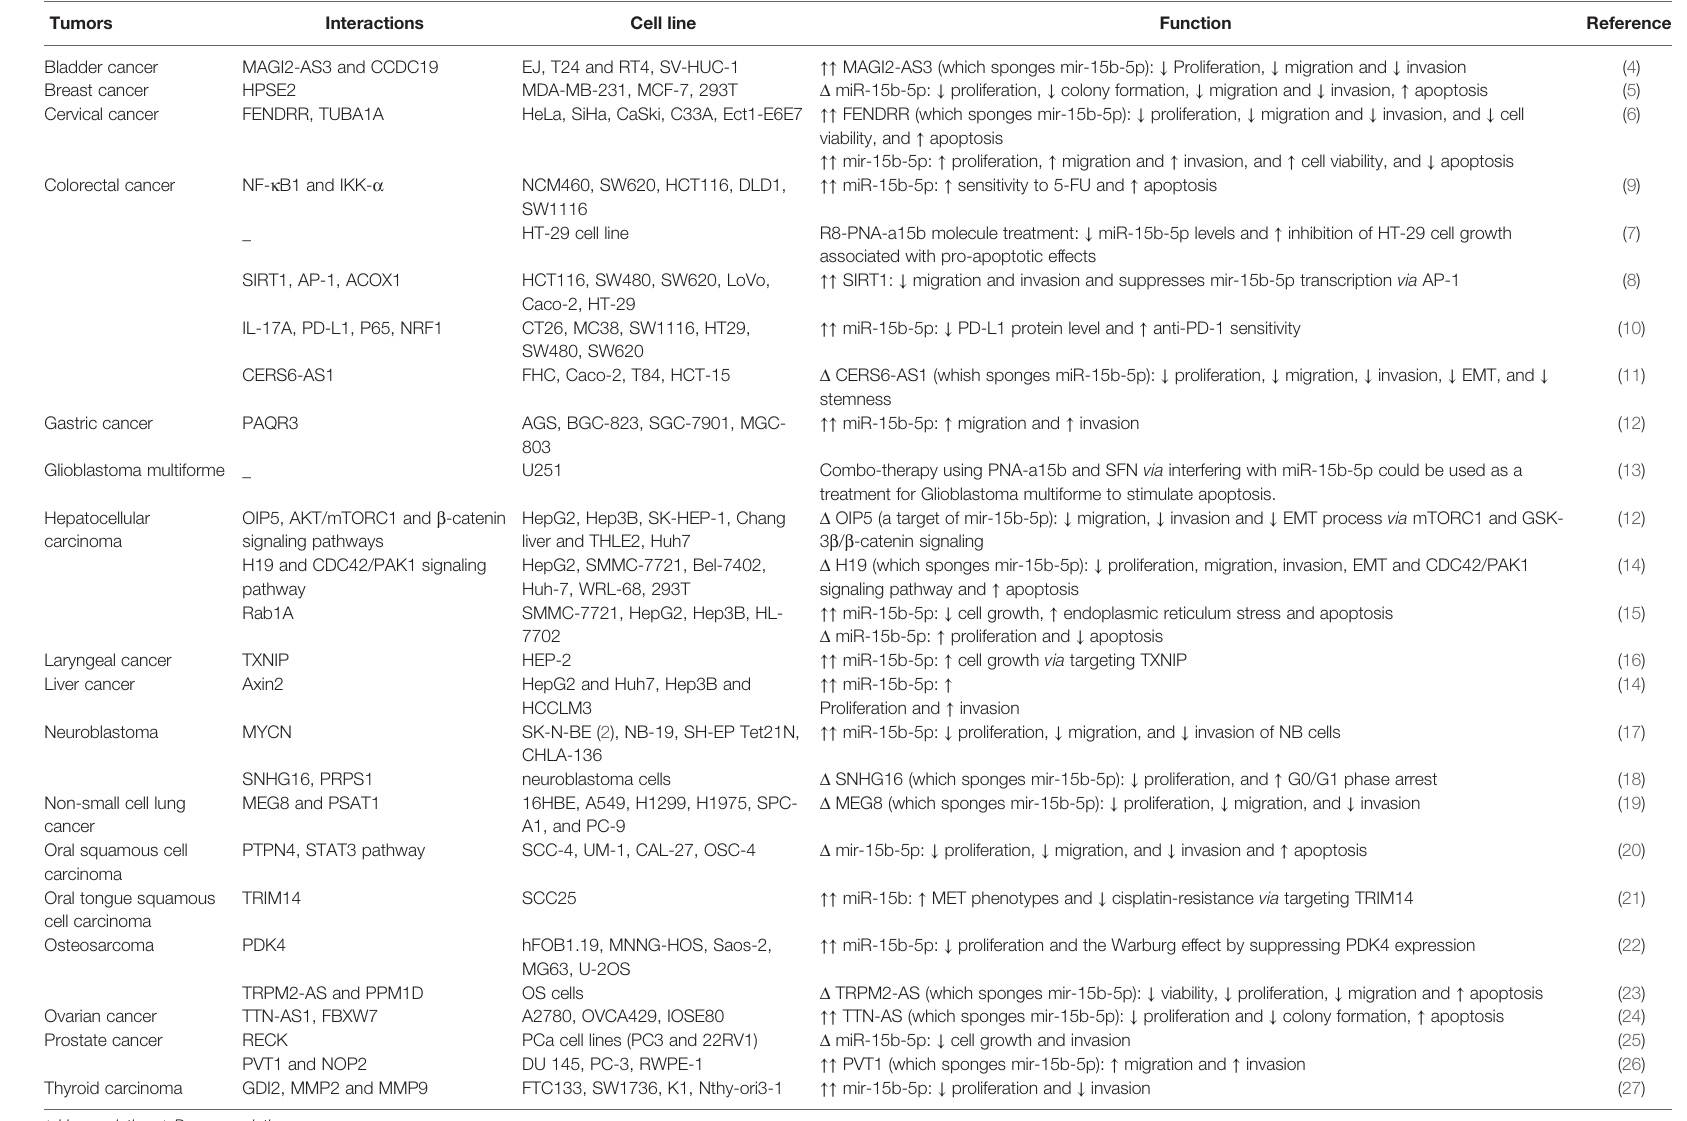
TABLE 1 | Summary of cell line studies on the role of miR-15b-5p in cancers ( D , knock-down or deletion; MET, mesenchymal-epithelial transition).